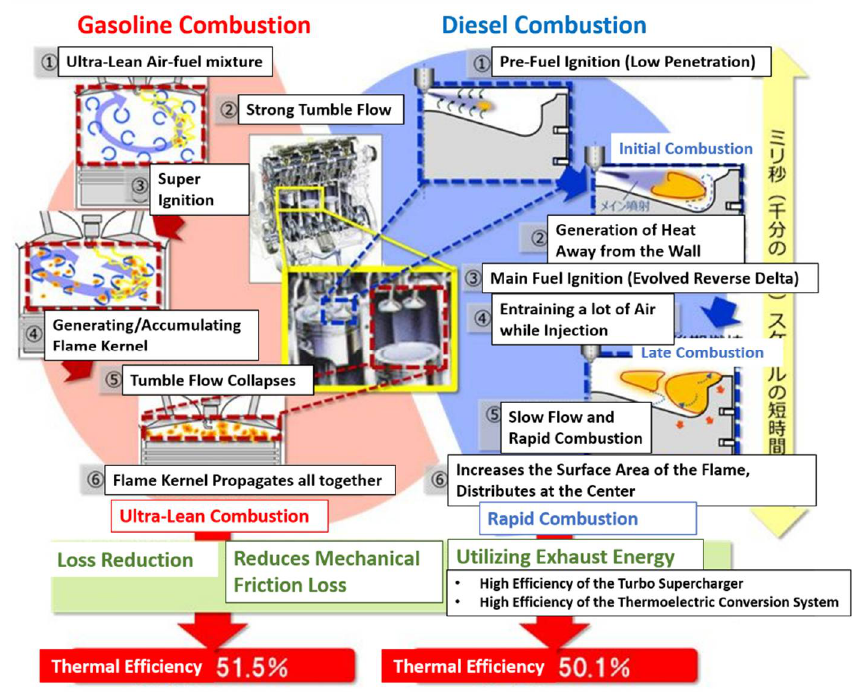
Figure 22. Outline of the achievement of the 50% thermal efficiency [149].